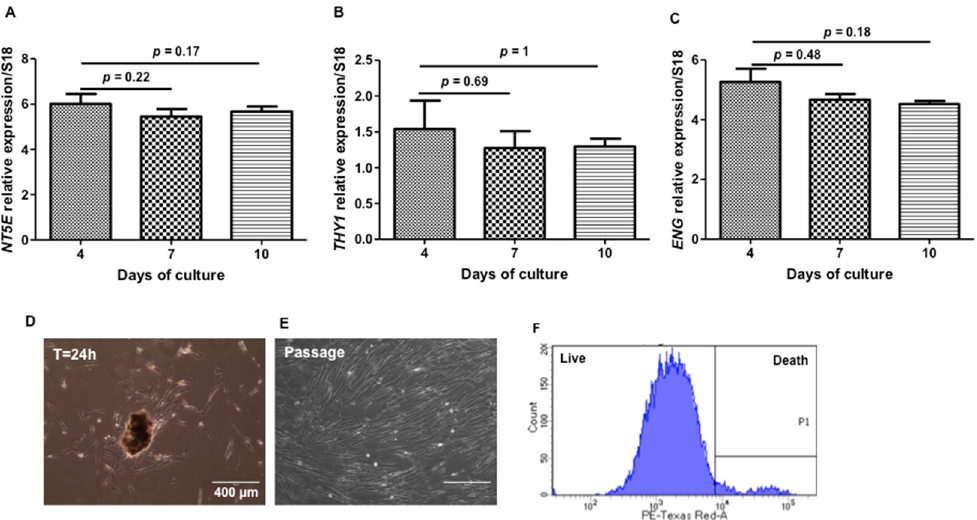
Figure 8. Cell phenotype over the time of the study . ( A – C ) Histograms of NT5E (CD 73), THY1 (CD 90), and ENG (CD 105) qRT-PCR analysis, respectively, showing non-significant regulation of MSCs markers; ( D ) WJ-MSC migration on plastic; ( E ) WJ-MSC morphology after passage; and ( F ) flow cytometry results obtained after Zombie ® labelling of amplified cells ( n = 6, Mann and Whitney statistical test).